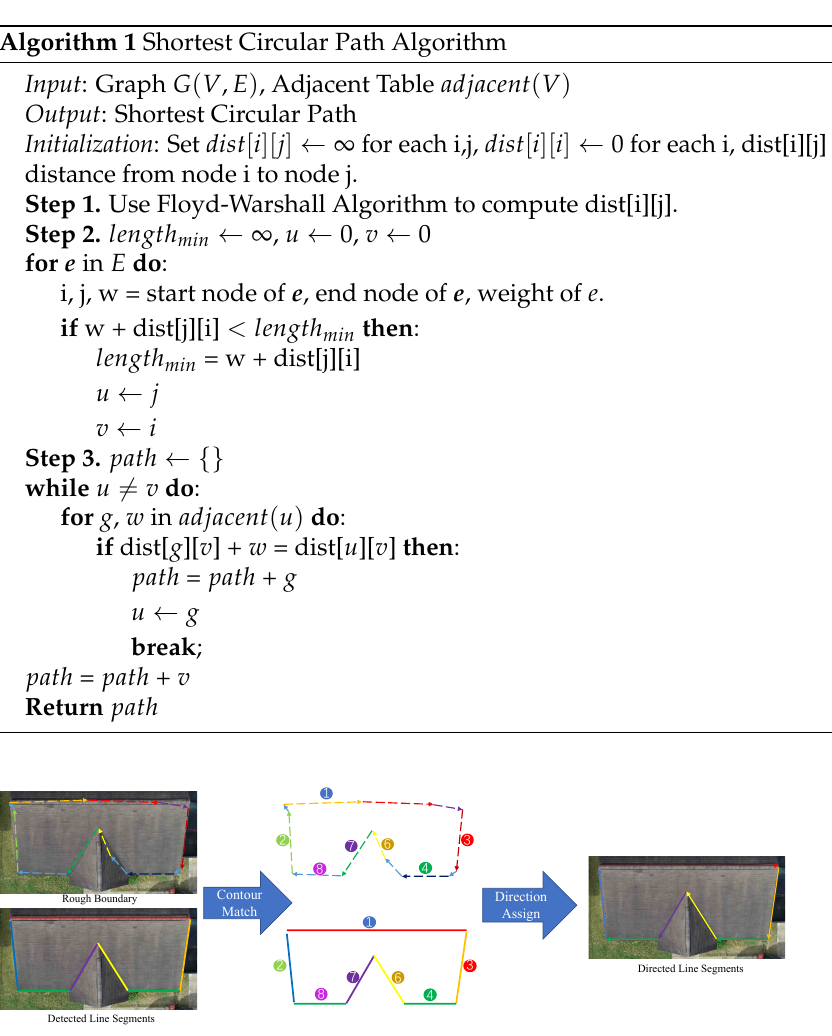
Figure 3. Line Segment Direction Acquisition. To assign line segments with proper direction, each detected line segment is matched with a directed edge in the facet rough boundary. As shown above, the matched pair is tagged with the same number. After the matching process, line segments are assigned with the direction of the matched edges in the rough